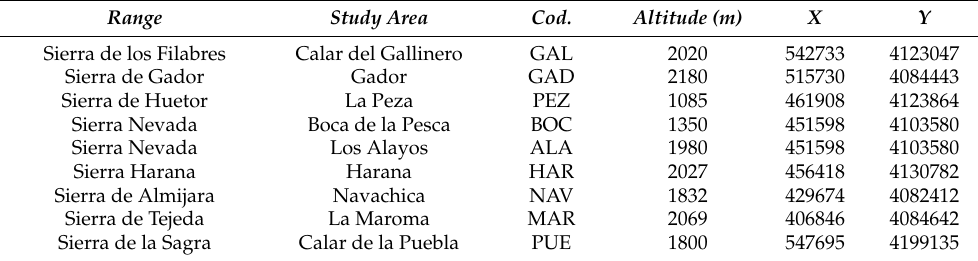
Table 1. Localities sampled with the acronyms (Cod.) used in the text.